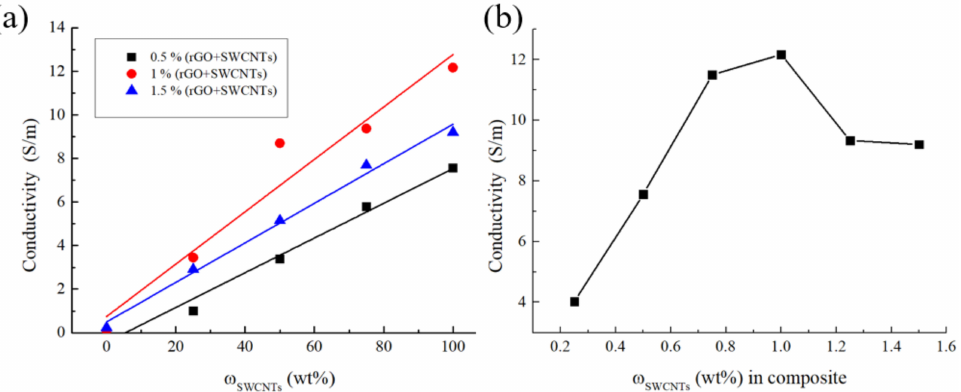
Figure 3. Dependence of the electrical conductivity on the mass content of SWCNTs in a mixture of carbon fillers ( a ), and dependence of the electrical conductivity on the mass content of SWCNTs in the composite ( b